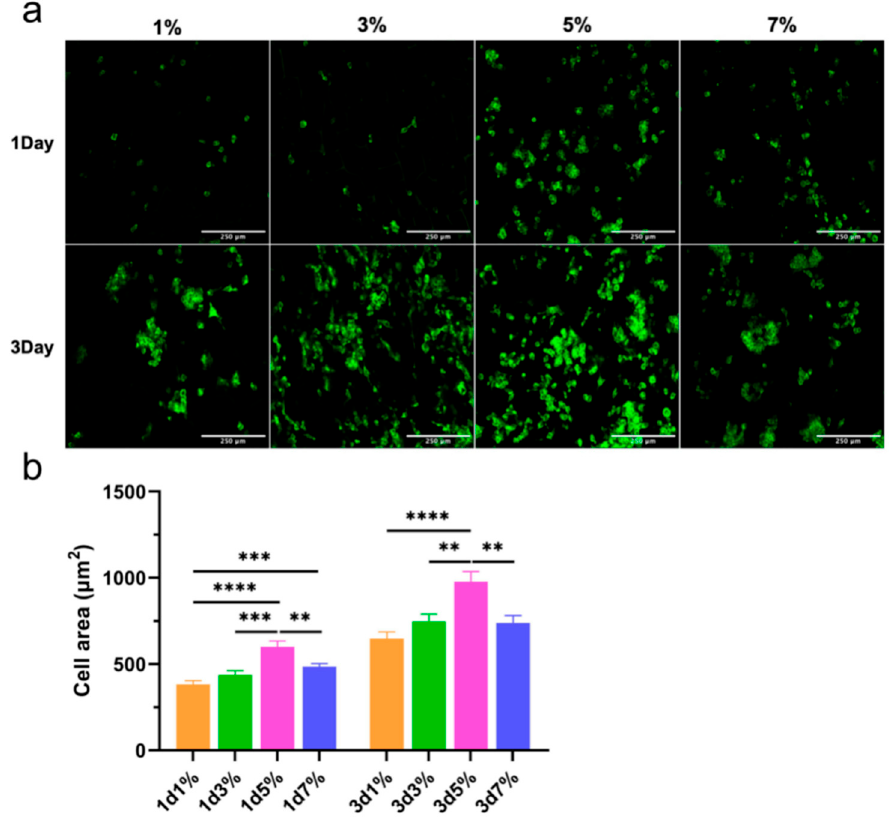
Figure 8. ( a ) RAW264.7 cells were cultured on different concentrations of chitosan freeze-dried scaf- folds and stained with phalloidin. ( b ) Quantitative statistics of cell area, n = 30, ** p < 0.01, *** p < 0.001, **** p < 0.0001.